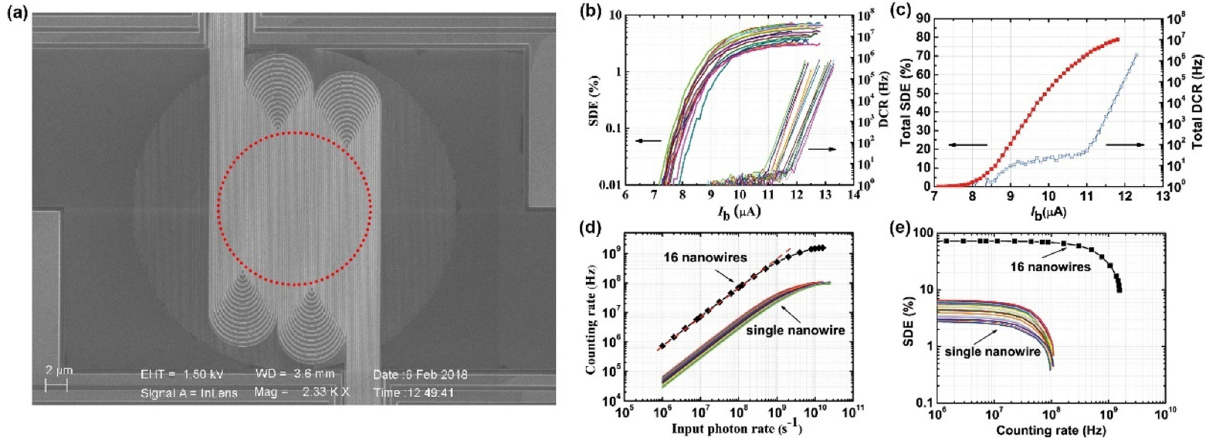
Figure 7: (a) SEM image of a 16-nanowire interleaved SNSPD. (b) SDE and DCR as functions of the bias current for single pixel in the 16-pixel SNSPD.(c) Total SDE and DCR as functionsof the bias current of the 16-pixel SNSPD.(d) The measured individualandcombined nanowireCRs versus the input photon rate. The red dashed line is a guide to the eye. (e) The individual and total SDEs as a function of the measured CR. The colored curves represent the results for each nanowire, whereas the dotted curve represents the total SDE obtained by summing for the 16 nanowires. Reproduced with permission. [99] Copyright 2019, IEEE Publishing